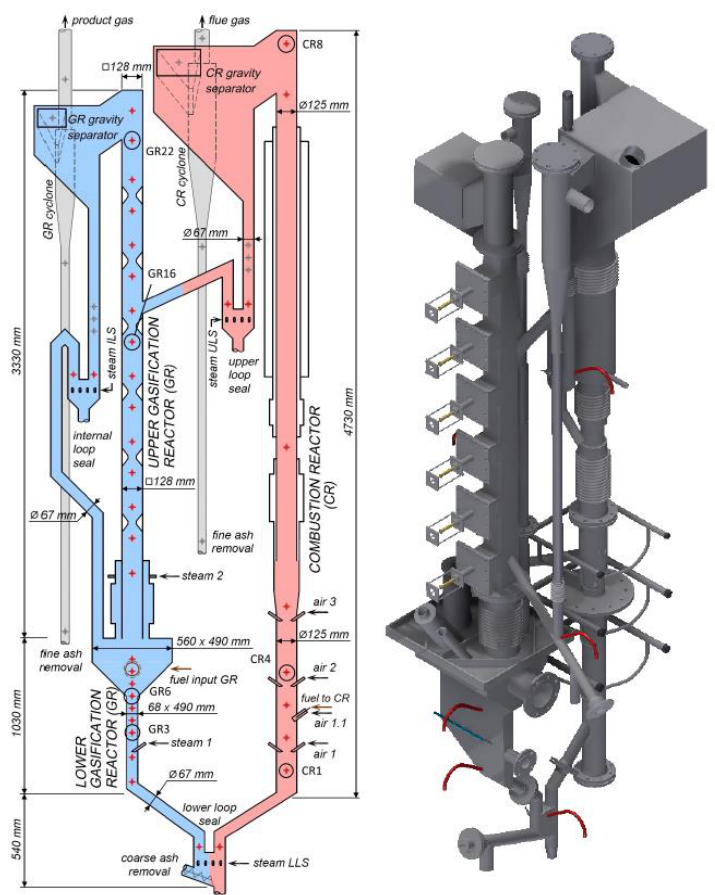
Figure 1. Scheme and 3Ddrawing of the 100 kW dual fluidized bed (DFB) steam gasification pilot plant [23].